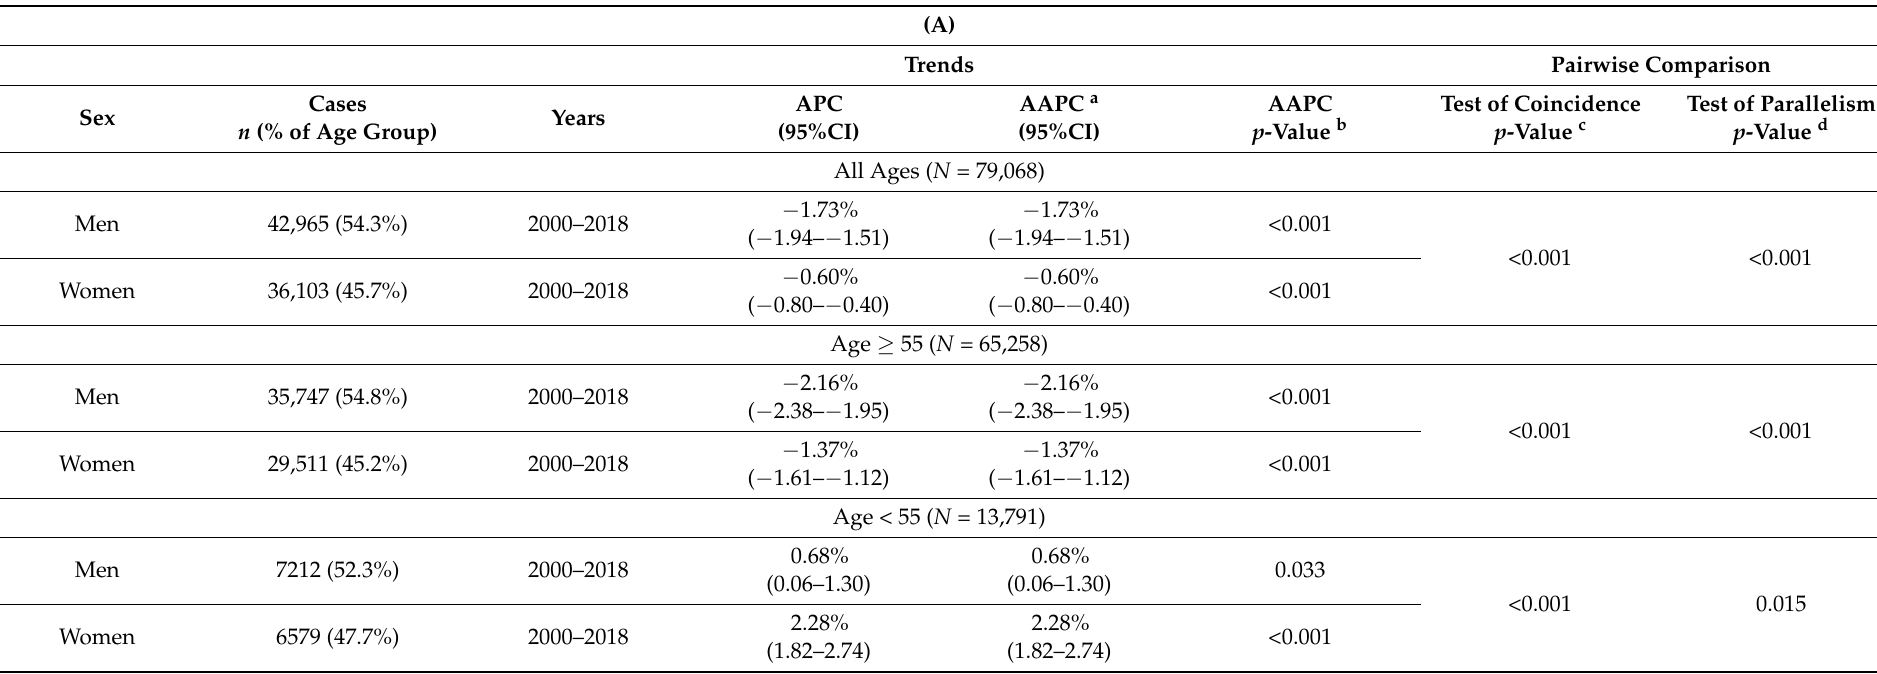
Table 2. ( A ) SEER Database (2000–2018): Age and Sex-Specific Trends of Non-cardia Gastric Cancer in the United States. ( B ) SEER-Excluded NPCR Database (2001–2018): Age and Sex-Specific Trends of Non-cardia Gastric Cancer in the United States. (A) Trends Pairwise